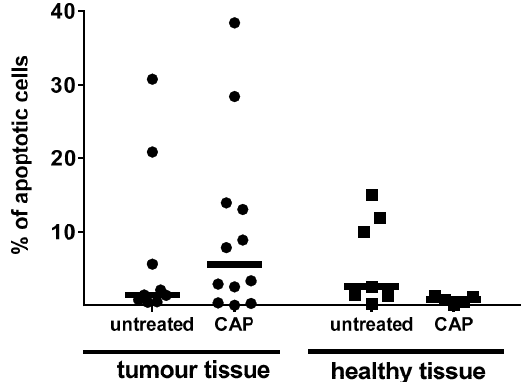
Figure 5. Induction of apoptotic cells by CAP application in tumour tissue in situ. TUNEL-positive cells were detected in several specimen of squamous cell carcinoma as well as in healthy tissue donated by the same patient. Results are displayed as scatter dot plot with a line at median. While healthy tissue revealed only very few TUNEL-positive cells after CAP exposure for 3 min the number increased in tumour tissue. Note the inter individual variance.